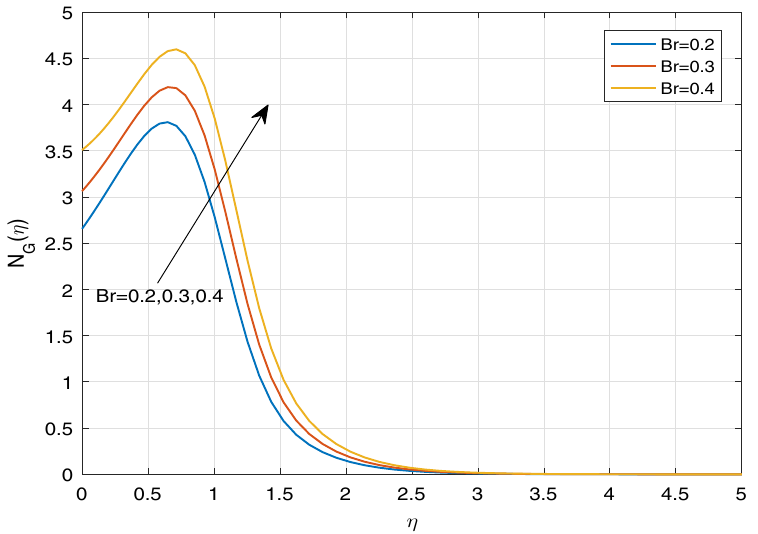
Figure 13. Sketch of N G against Br .